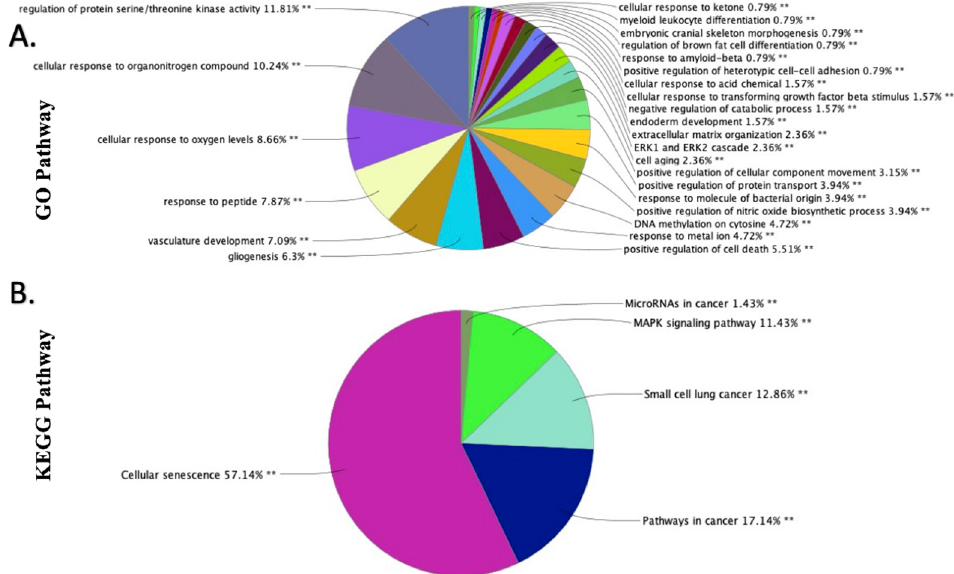
Figure 5. GO and KEGG functional enrichment analysis of DEmiRNAs: GO enrichment analysis shows the biological processes and cellular components of the DEmiRNAs in the EAT of CAD patients ( A ). KEGG enrichment analysis shows the molecular functions associated with the DEmiRNAs ( B ). ClueGO v2.5.8 and CluePedia v1.5.8 in Cytoscape v3.9.0 were used for enrichment analysis. ** indicates p < 0.01 for the associations.